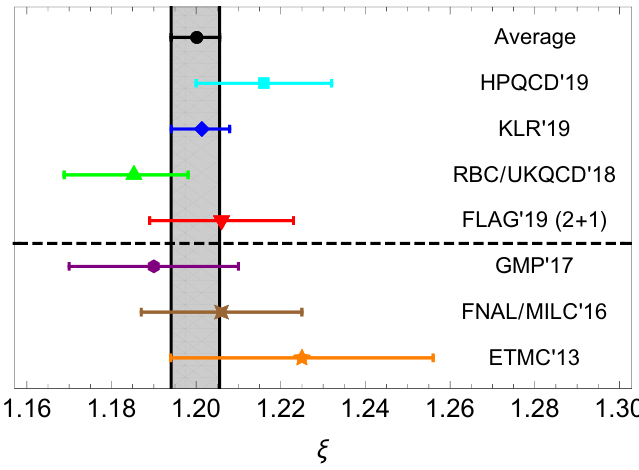
Figure 4 . Comparison of determinations of the SU(3)-(cid:13)avour breaking ratio (cid:24) . The gray band corresponds to the weighted average of the results [13, 24{26]. Below the dashed line we also show the values from [12, 21, 31] which are not included in the